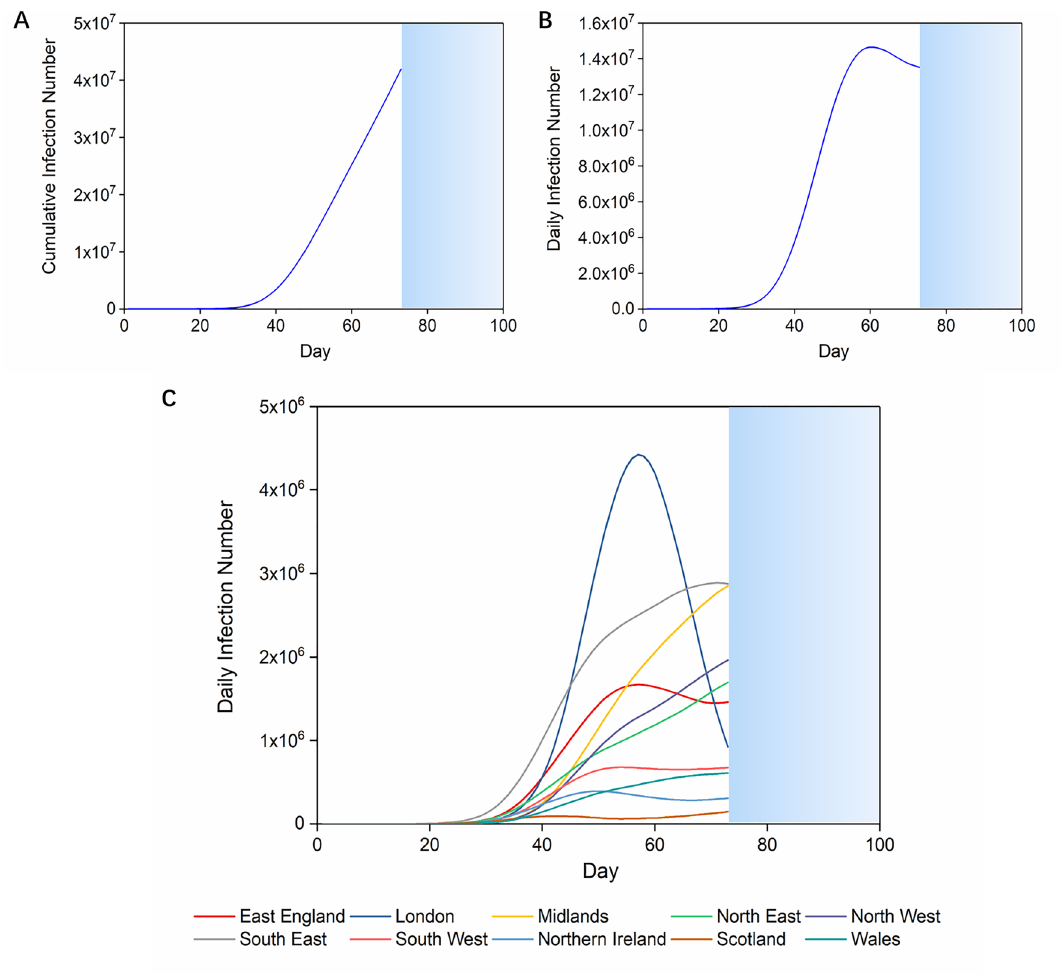
Figure 1. Infection curves without interventions in the UK. ( A , B ) The cumulative/daily infection curve without interventions in the UK. The simulation stops when cumulative infection number exceeds the regional population (blue sections). ( C ) The daily infection curves for regions in the UK without interventions. The simulation stops when cumulative infection number exceeds the regional